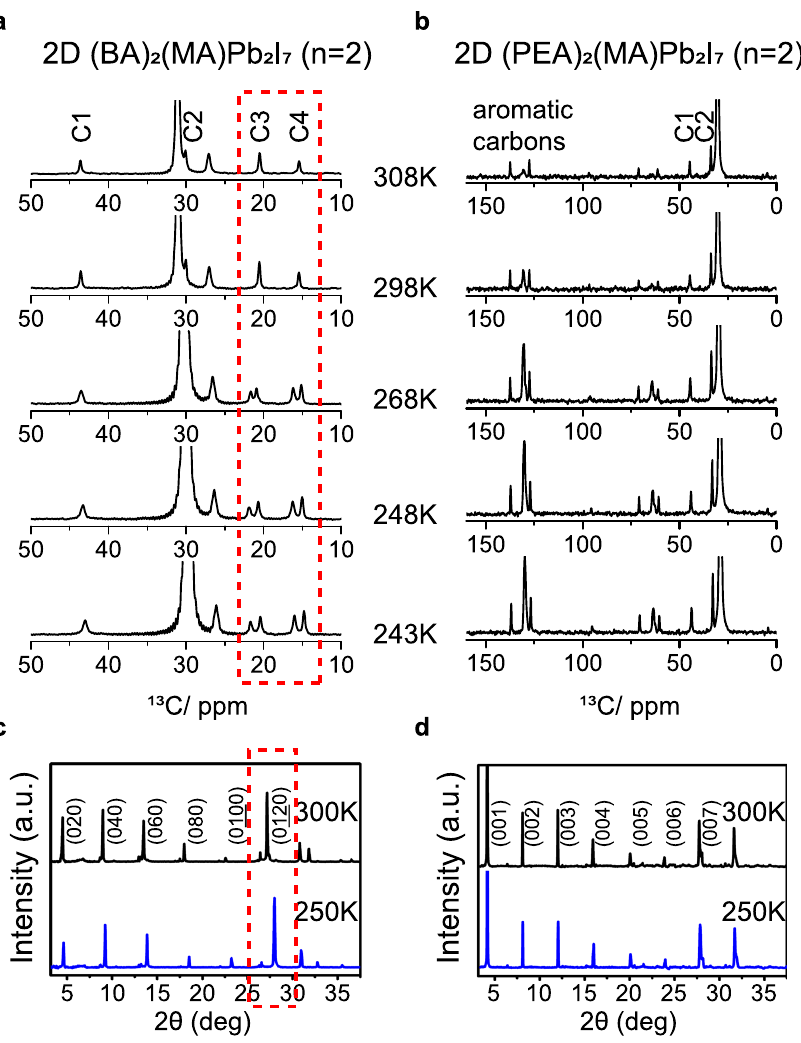
Fig. 5 The 13 C CPMAS spectra and PXRD spectra of 2D OIHP crystals ( n = 2). The 13 C CPMAS spectra of a 2D (BA) 2 ( 13 C, 15 N-MA)Pb 2 I 7 ( n = 2) and b 2D (PEA) 2 ( 13 C, 15 N-MA)Pb 2 I 7 ( n = 2) recorded at various temperatures, ranging from 308 to 243 K. The PXRD patterns of c 2D (BA) 2 MAPb 2 I 7 ( n = 2) and d 2D (PEA) 2 MAPb 2 I 7 ( n = 2) measured at 300 K (black colour) and 250 K (blue colour). The red dashed boxes highlight the obvious changes of the 13 C CPMAS and PXRD spectra during